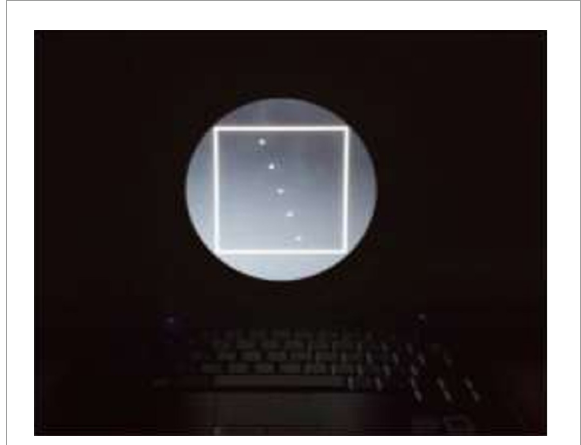
FIGURE1 Concealment of the vertical edges of the laptop with a circular black paper ring stuck to the laptop